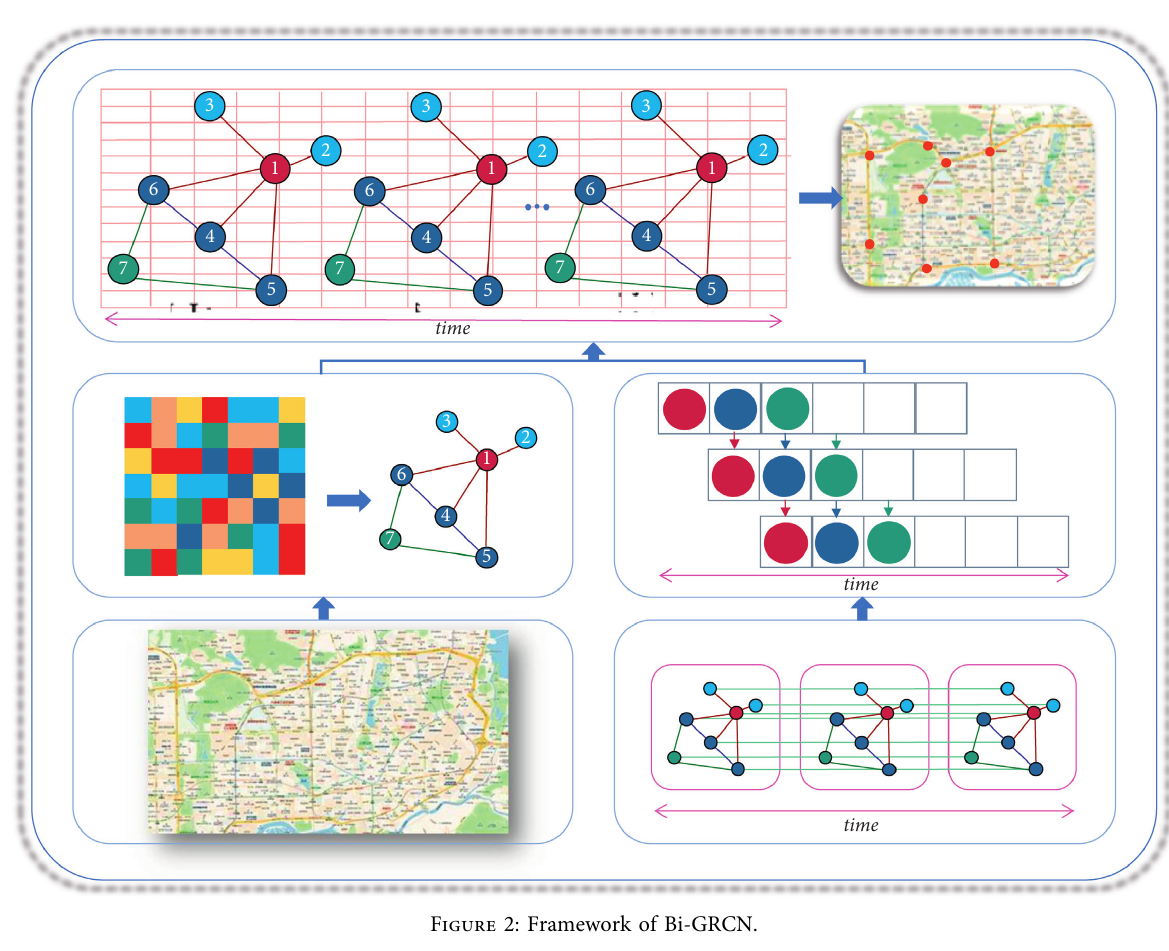
Figure 2: Framework of Bi-GRCN.